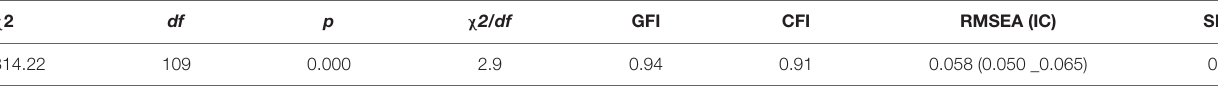
TABLE 4 | Goodness of fit indicators for the model.